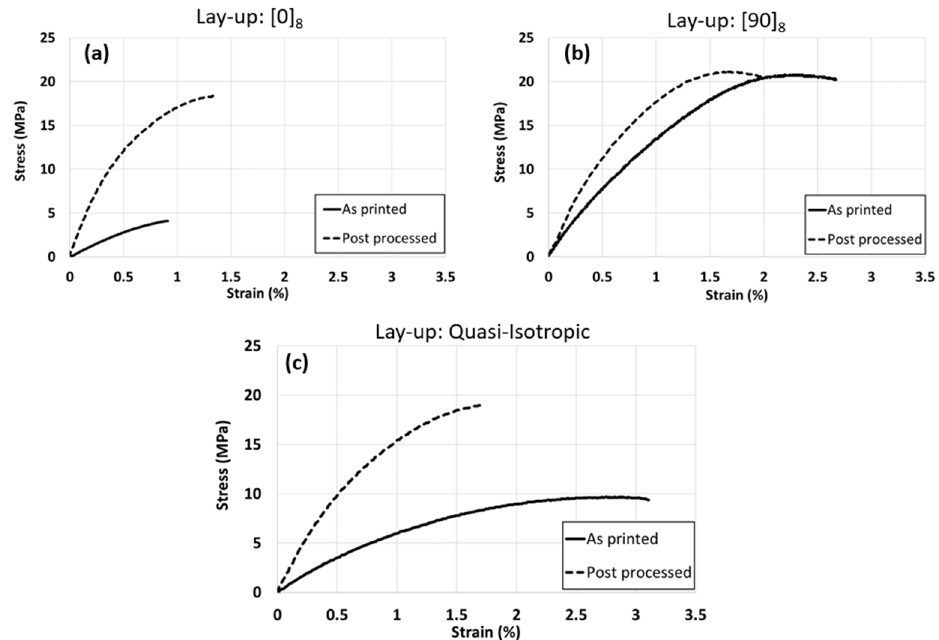
Figure 6. Tensile test comparison between post-processed and as-printed of the lay-ups: ( a ) unidirectional 0°; ( b ) unidirectional 90°; and ( c ) quasi-isotropic.